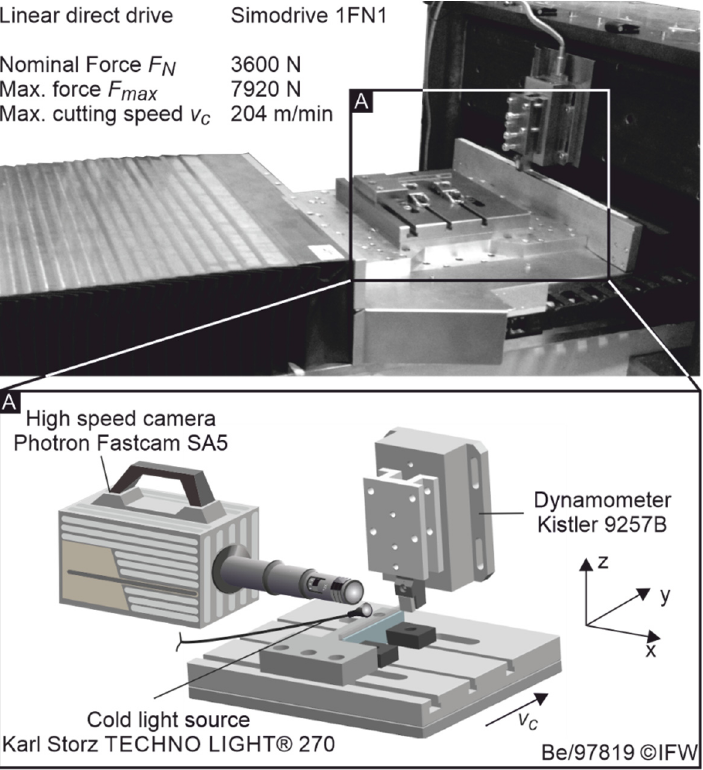
Figure 2. Experimental setup for planing investigations.